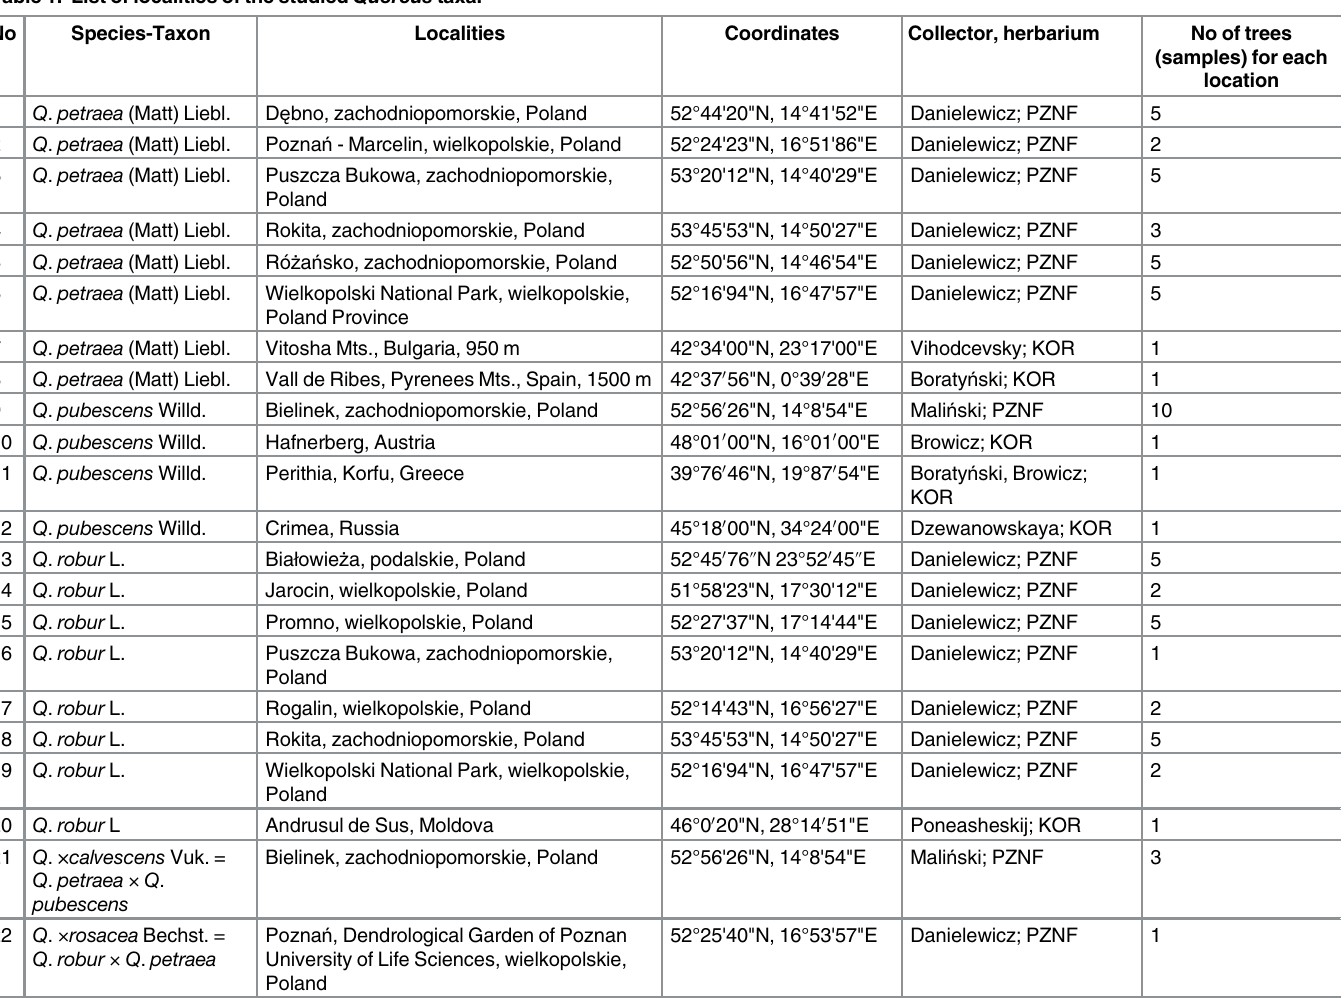
Table 1. List of localities of the studied Quercus taxa.